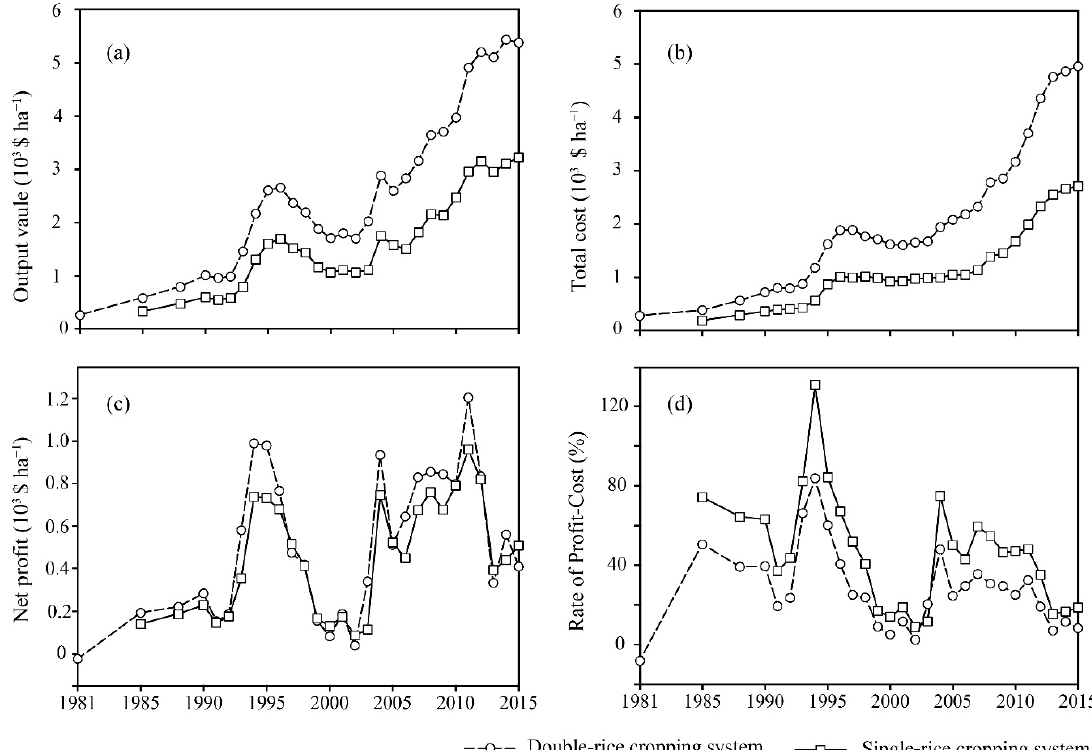
Figure 3. Rice production statistics for single rice cropping systems (SRCS) during the period of 1981–2015 and double rice cropping systems (DRCS) during the period of 1978–2015. ( a ) Output per unit area. ( b ) Total cost per unit area. ( c ) Net profit per unit area. ( d ) Profit-cost ratio.